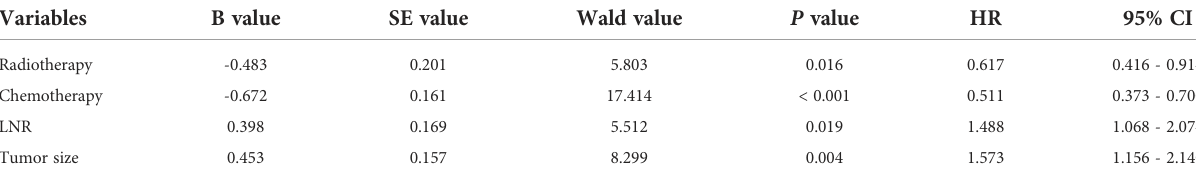
TABLE 4 Multivariate analysis of different in fl uencing factors in ASCP patients. Variables